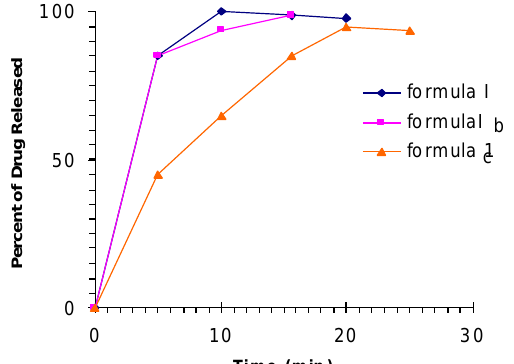
Fig. 4 : Effect of mode of incorporation of disintegrant on the release of Orphendrine from